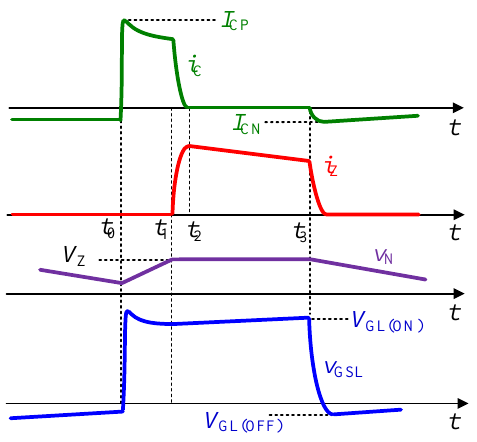
Figure 4. Switching waveforms of the proposed gate driver.